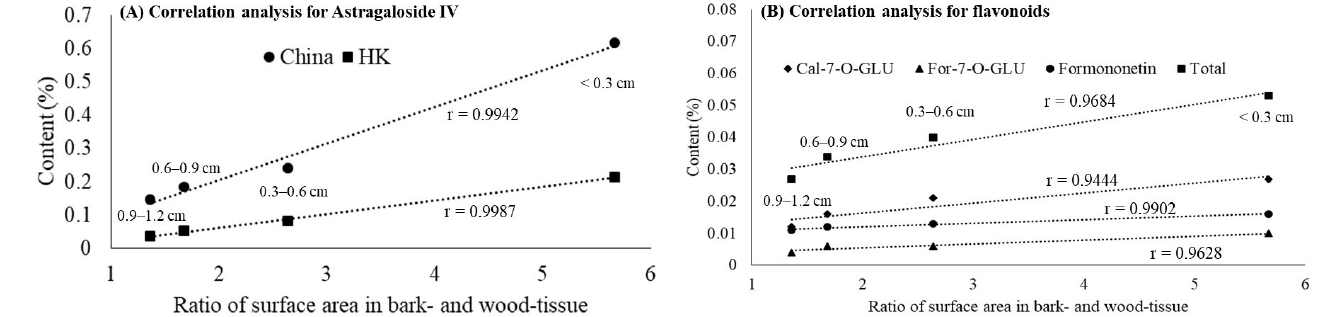
Figure 4. Effects of bark- and wood-tissue with diverse powder particle size on the content of Astragaloside IV ( A ) and flavonoids ( B ) in Astragali radix . Data are expressed as mean ± SD from three separate experiments; means not sharing an alphabetic letter (left panel: lowercase for China and uppercase for HK; right panel: lowercase for formononetin and uppercase for total flavonoids) differ statistically ( p < 0.05). Total flavonoids is the sum of Cal-7-O-GLU, For-7-O-GLU, and formo- nonetin. Abbreviations (alphabetically): Cal-7-O-GLU, Calycosin-7- O -β- D -glucopyranoside; China,